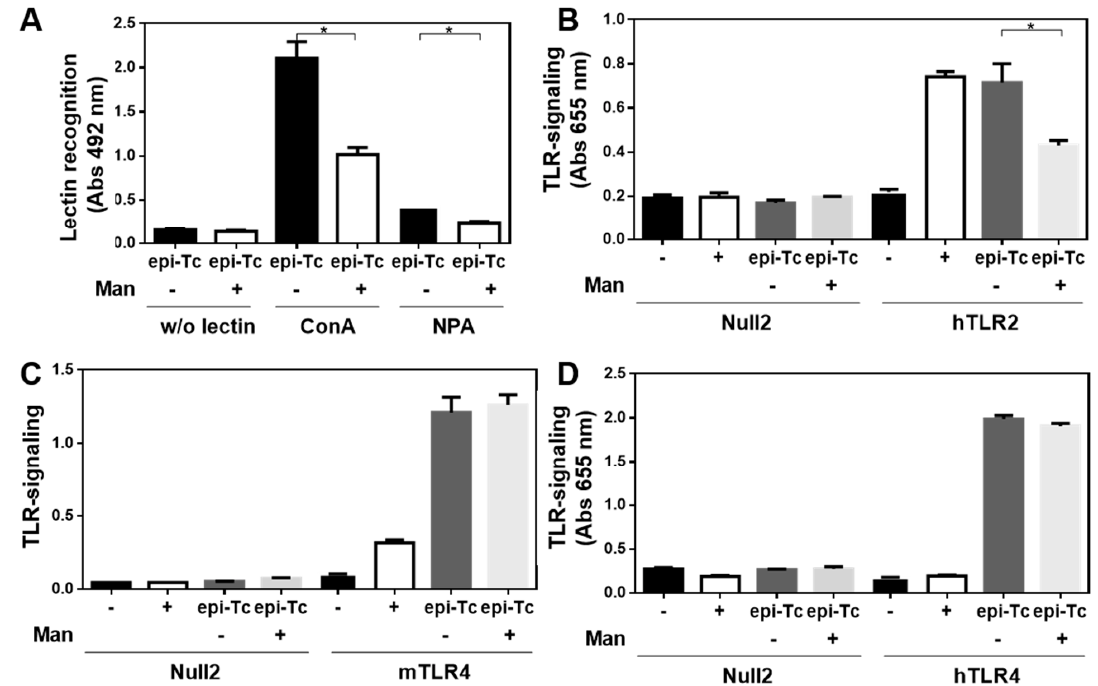
Figure 9. Mannose-rich glycoconjugates in T. cruzi lysate induce human TLR2 signalling: ( A ) ConA and NPA lectin recognition of T. cruzi lysates subjected to immobilised α -mannosidase. T. cruzi lysates subjected to immobilised α -mannosidase (Man) were incubated with HEK-blue-293 cells (50,000/well) expressing either human TLR2 (hTLR2, ( B ), mouse TLR4 (mTLR4, ( C ) and human TLR4 (hTLR4, D ). Null2 consisted of control cells with basal endogenous TLR expression. Quantification of phosphatase alkaline in cell culture was detected in the culture supernatant by specific sandwich ELISA or by direct absorbance measure with a spectrophotometer. Positive controls (+) consisted of LPS for TLR4 and in PAM3CSK for TLR2, while the negative control ( − ) consisted of cells alone. Representative results from two independent experiments are shown (±SEM, indicated by error bars). Asterisks indicate statistically significant differences (* p < 0.05) by student t -test.